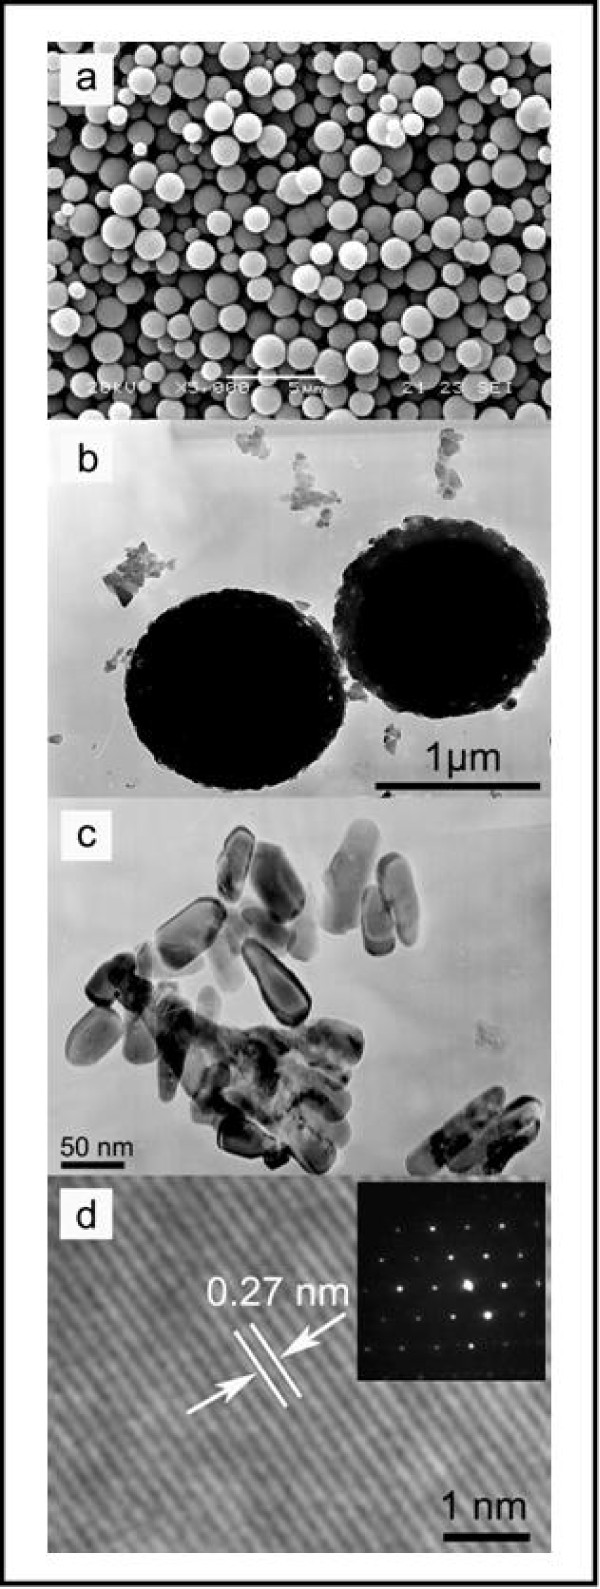
SEM, TEM (a, b), HRTEM (c), and SAED (inset) (d) for Zn0.93Mn0.07O HMSs.